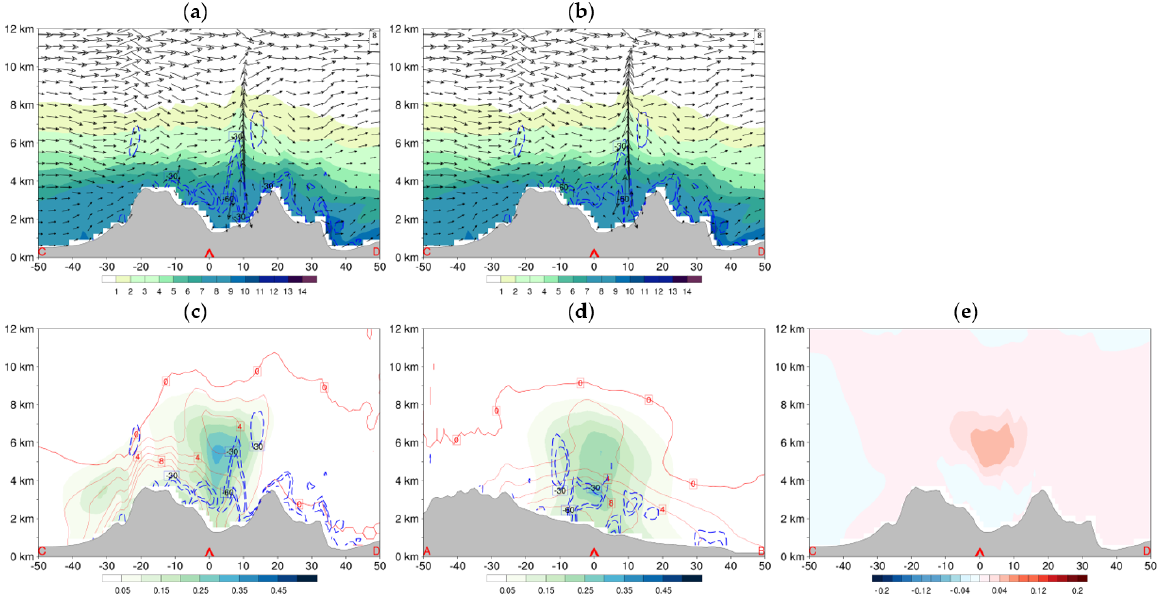
Figure 9. Vertical cross-section of the analysis and the increment of water vapor (unit g/kg) along line CD at 0800 UTC. ( a ) The analysis from C2Rad. ( b ) The analysis from C2RadBy. ( c ) The increment from C2Rad. ( d ) The increment from C2RadBy. ( e ) The difference of increment between C2Rad and C2RadBy. The shades in each plot indicate the water vapor mixing ratio (unit g/kg). The solid red lines indicate the increment of temperature (unit 0.001 °C). The dashed blue lines indicate negative divergence (unit 1/s).